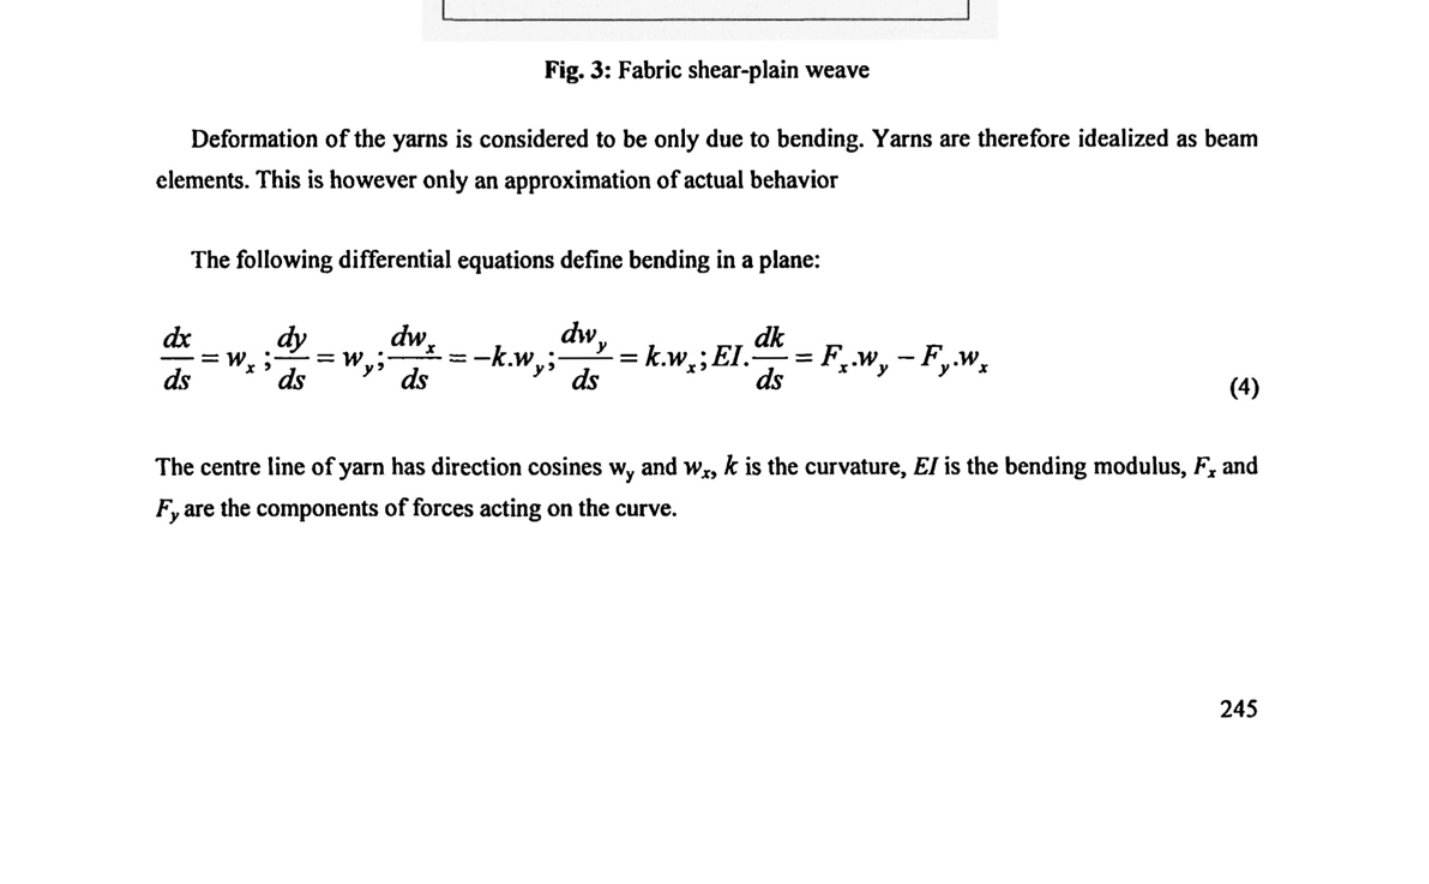
Fig. 3: Fabric shear-plain